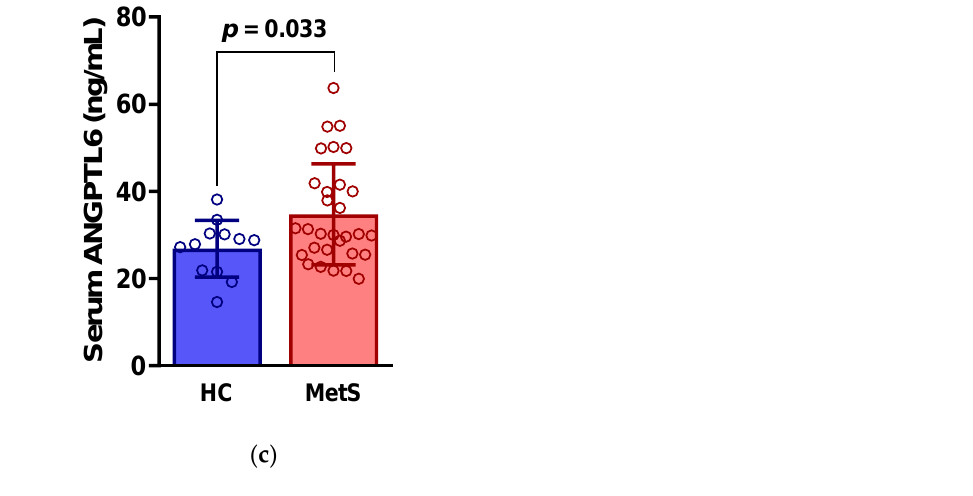
Figure 1. Serum levels of ( a ) fibroblast growth factor 21 (FGF21), ( b ) growth differentiation factor 15 (GDF15), and ( c ) angiopoietin-like 6 (ANGPTL6) between metabolic syndrome (MetS) patients and age-matched healthy controls (HC). Circles are individual values.